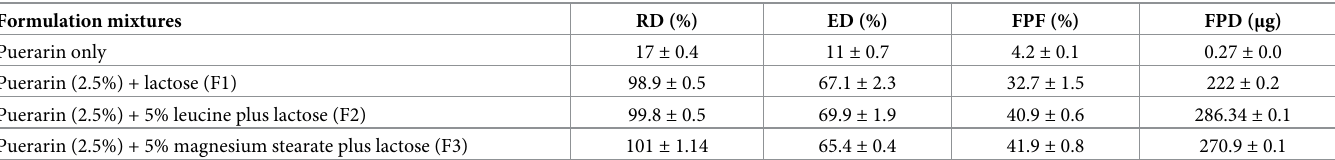
Table 1. Puerarin dry powder inhaler (DPI) formulations and their dispersion behaviour. Formulation